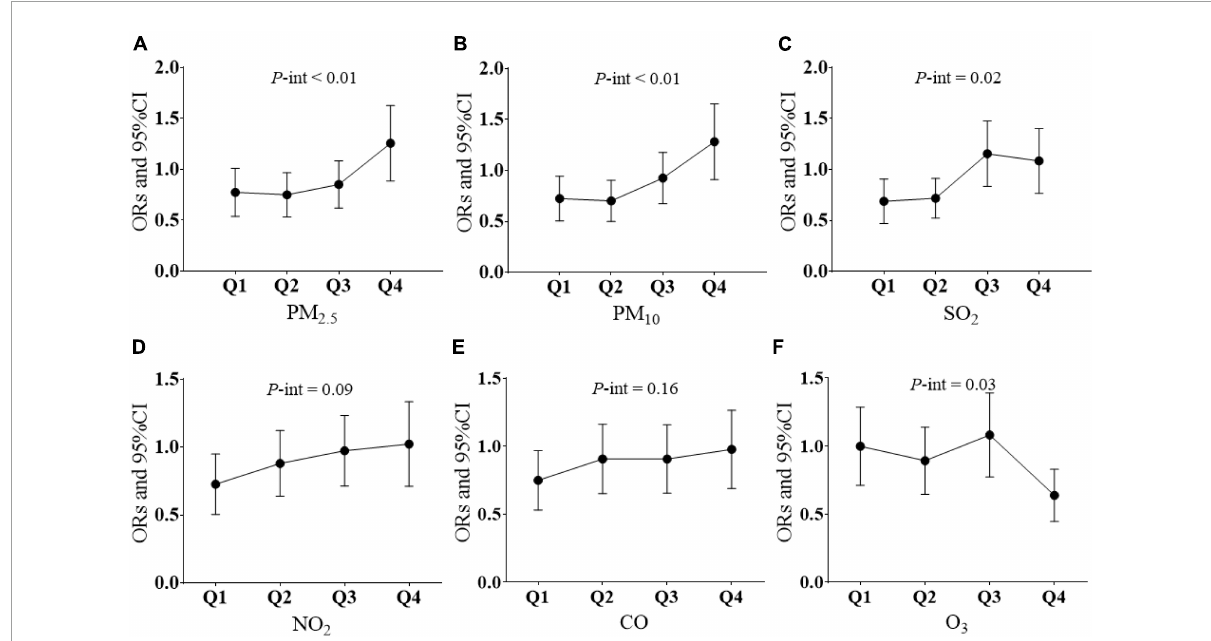
FIGURE2 Modifying effect of air pollution on CQI and GDM. (A) Association between every 4-point CQI increase and GDM according to four quantiles of PM 2 . 5 exposure levels. (B) Association between every 4-point CQI increase and GDM according to four quantiles of PM 10 exposure levels. (C) Association between every 4-point CQI increase and GDM according to four quantiles of SO 2 exposure levels. (D) Association between every 4-point CQI increase and GDM according to four quantiles of NO 2 exposure levels. (E) Association between every 4-point CQI increase and GDM according to four quantiles of CO exposure levels. (F) Association between every 4-point CQI increase and GDM according to four quantiles of O 3 exposure levels. P-int, P -value for interaction. Multiple logistic regression models were adjusted for age; BMI, race family income; education level; occupation; family history of diabetes or GDM; comorbidities; parity; smoking and alcohol consumption; physical activity; daily intake of total energy, protein, and fat; and household cooking; Q1, the first quartile; Q2, the second quartile; Q3, the third quartile; Q4, the forth quartile; P -int, P -value for interaction.